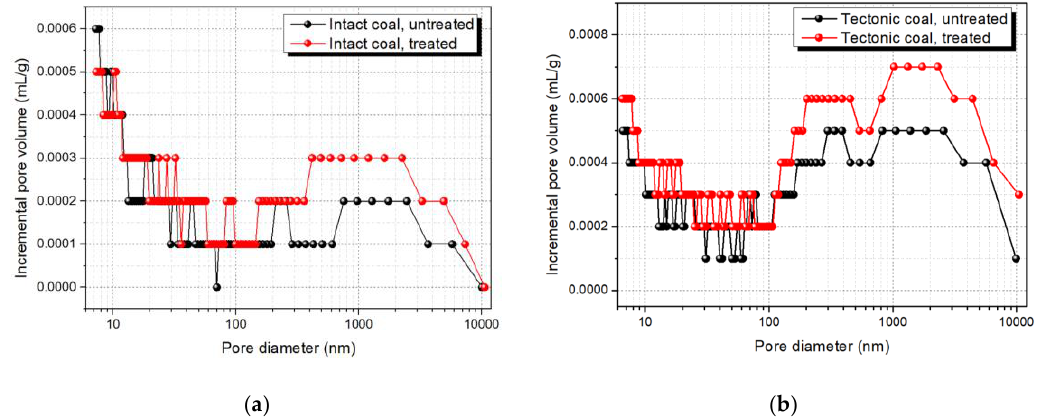
Figure 5. Pore size distributions determined by mercury intrusion porosimetry (MIP) for samples of ( a ) intact coal and ( b ) tectonic coal with and without supercritical CO 2 (ScCO 2 ) treatment. Table 2. Mercury intrusion porosimetry porosities and pore volume distributions for supercritical CO 2 (ScCO 2 )-treated and untreated coal samples.